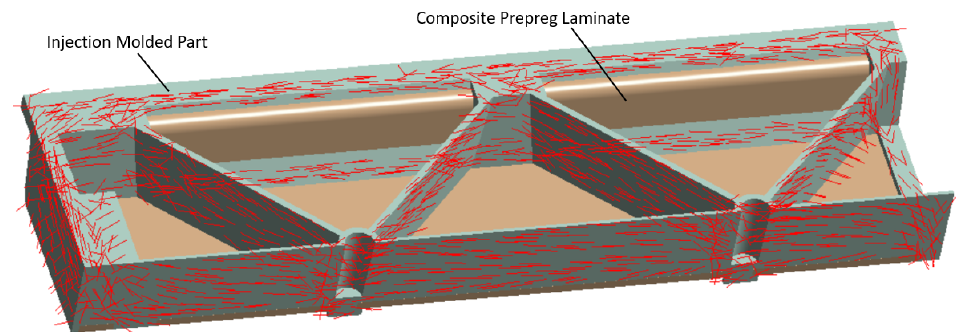
Figure 11. Main fiber directions of the PP/GF30 short fiber-reinforced thermoplastic composite mapped to the meshed geometry of the test bending structure using the orientation tensor output from the injection molding simulation. The injection molded part is directly bonded to the continuous fiber-reinforced laminate using contact elements.